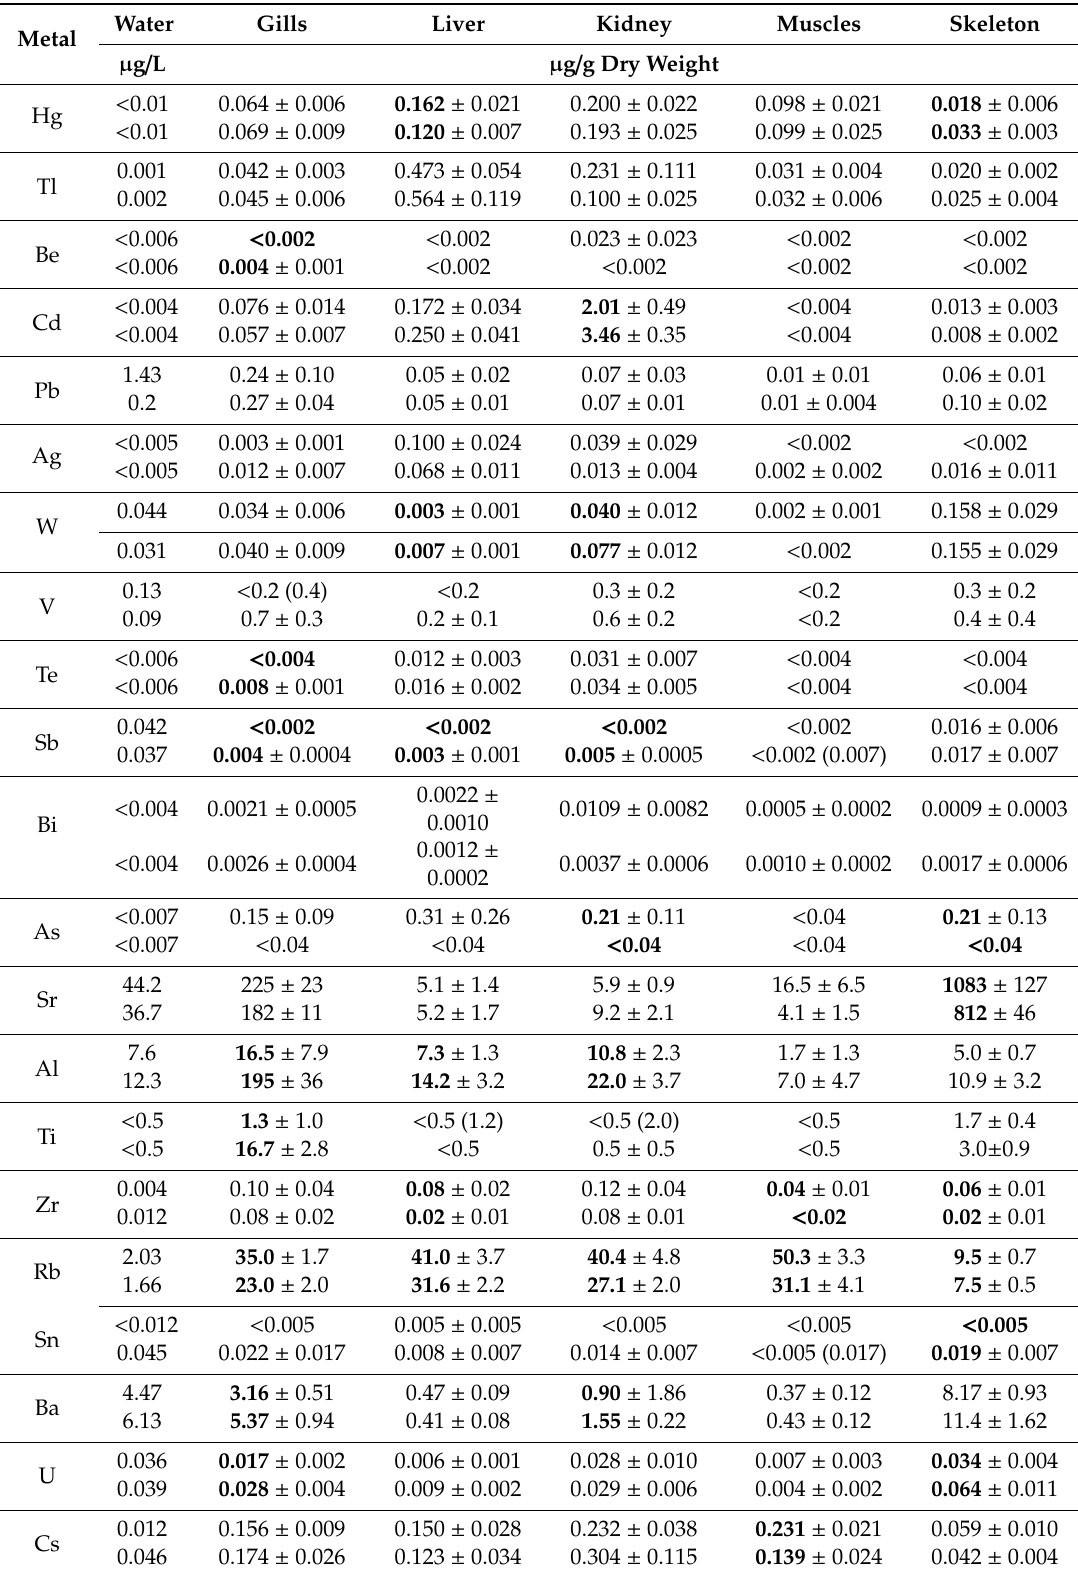
Table 2. Average values and standard errors of the toxic metal concentrations in the water, organs and tissues of the whitefish caught from area I-7 (top line) and area I-8 (bottom line). The maximum values are shown in brackets. The bold type shows a reliable di ff erence (with a significance level p < 0.05) in average